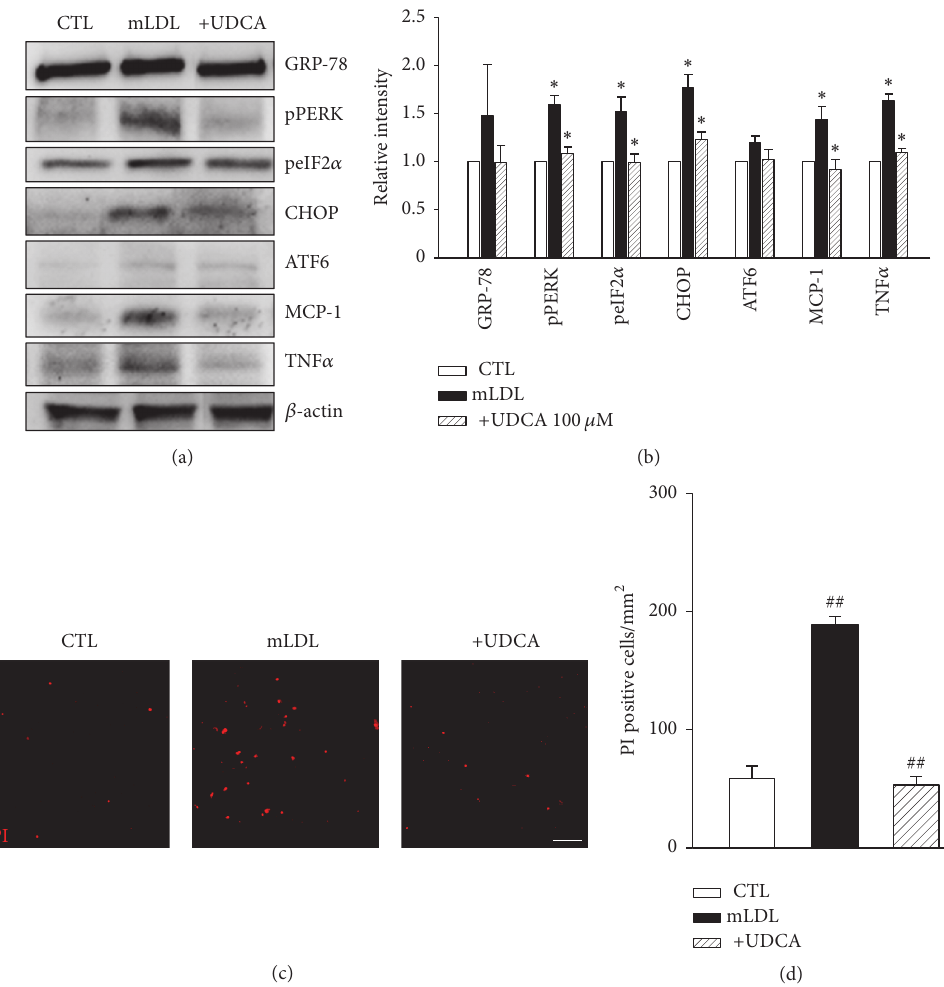
Figure 6: mLDL-induced UPR, inflammatory cytokine expression, and cell death are attenuated by UDCA in retinal pericytes. (a) Typical results of four independent western analyses are shown. (b) Levels of pPERK, peIF2 𝛼 , CHOP, and MCP-1 were increased and attenuated upon cotreatment with UDCA. GRP78, ATF6, and TNF- 𝛼 did not display significant changes in expression. (c, d) PI staining demonstrating the protective effect of UDCA against cell death in mLDL-exposed retinal pericytes. Original magnification: × 100; scale bar: 100 𝜇 m. CTL: control pericytes, mLDL: mLDL-exposed pericytes, and +UDCA: mLDL-exposed pericytes cotreated with UDCA, ∗ 𝑃 < 0.05, ## 𝑃 <